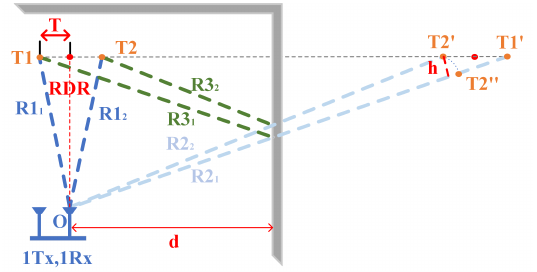
Figure 10. Distinguishing